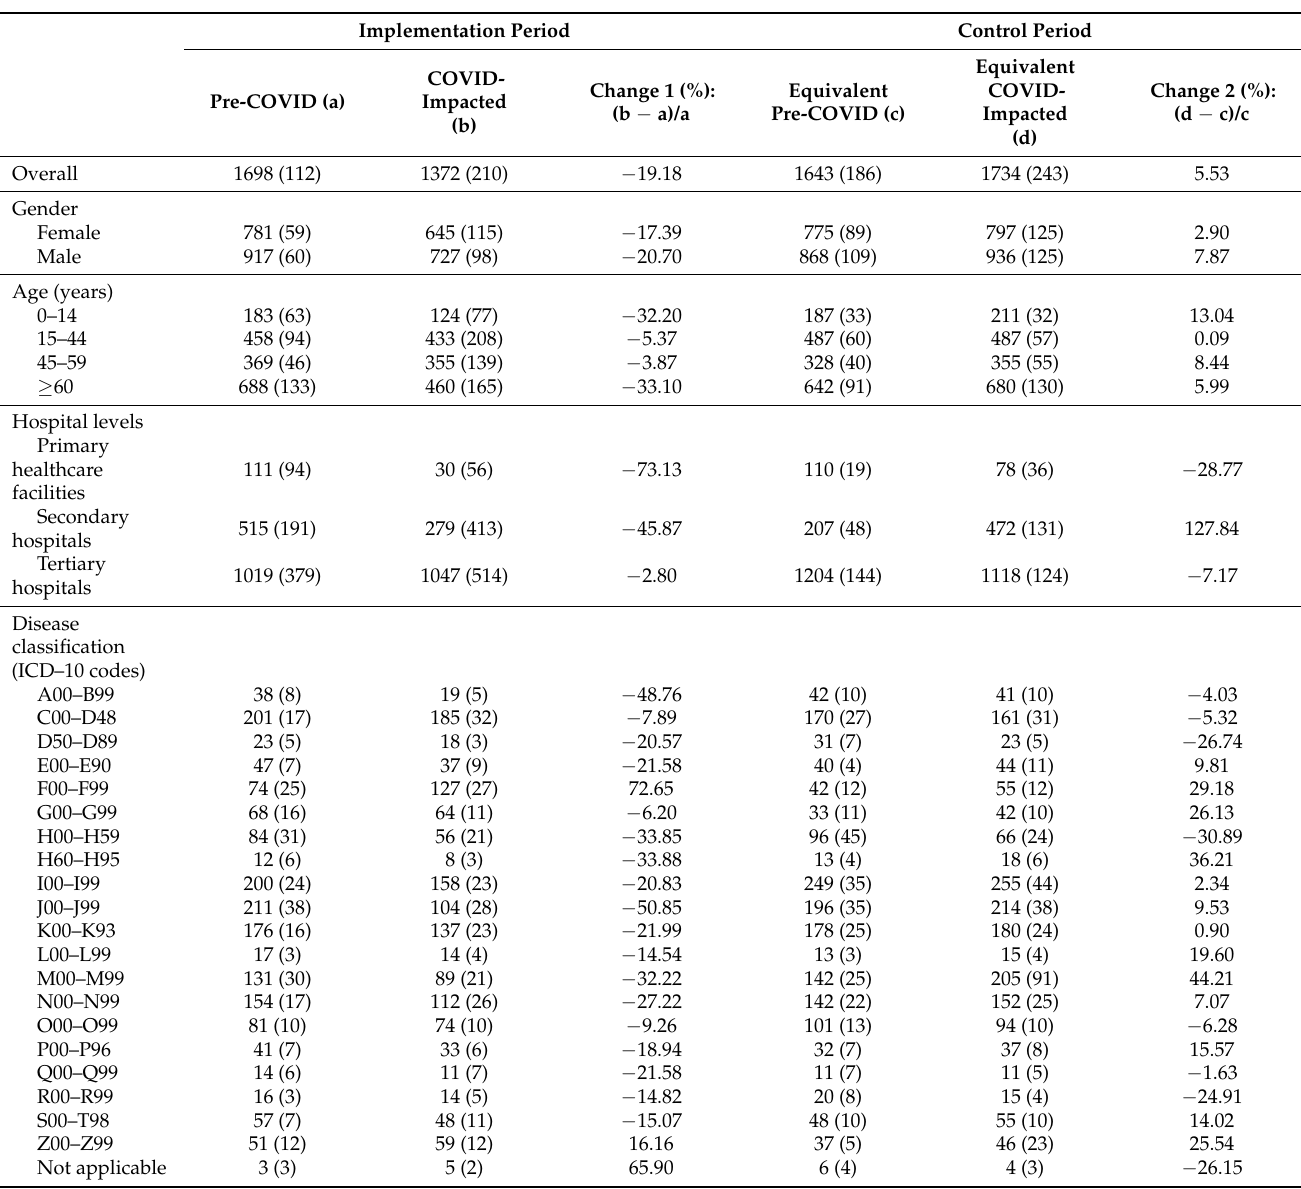
Table 2. Average monthly hospital visits in out-of-county but within-city areas for rural residents, shown as mean